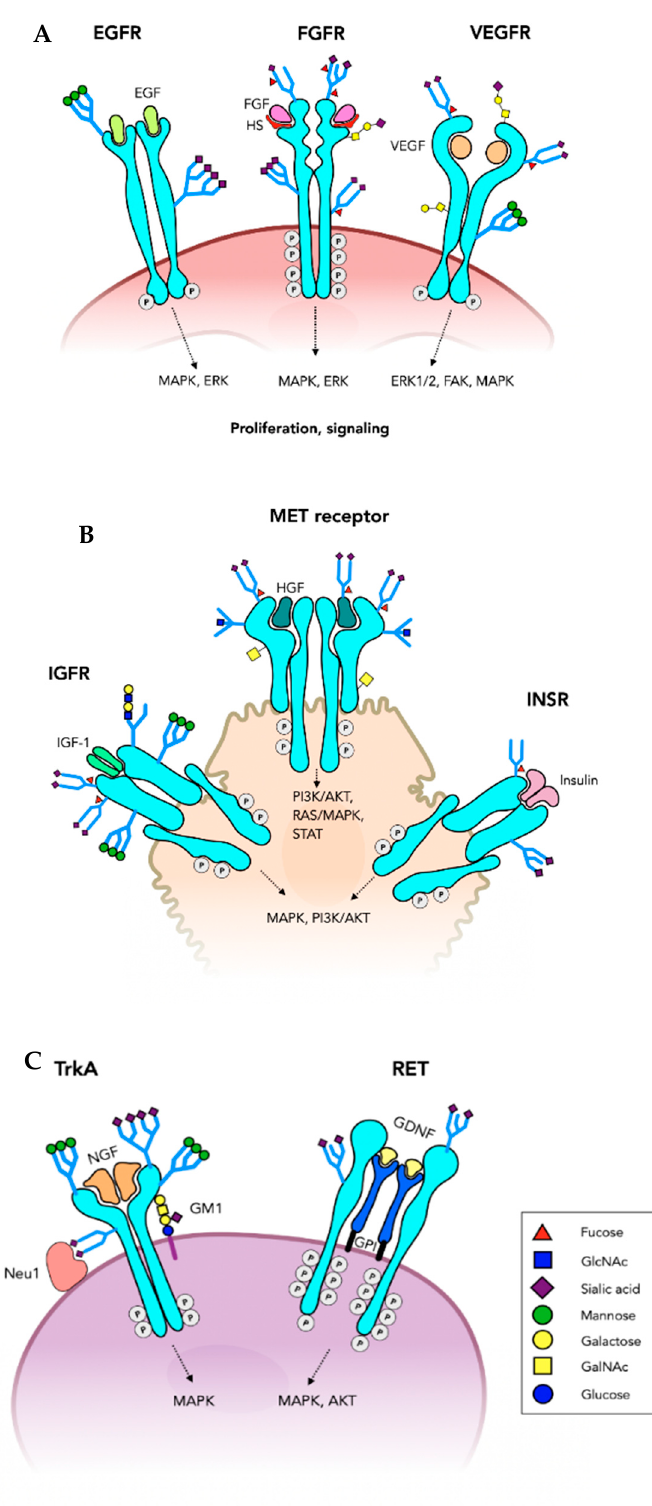
Figure 2. Tyrosine kinase receptors. Growth factor receptors have an extracellular domain that binds a growth factor and a cytoplasmic Tyrosine kinase domain (oncoprotein) that is essential for the signaling through a number of pathways that promote cell proliferation. Many of these receptors are of critical importance in tumor growth. Ligand binding induces receptor dimerization and activation of the Tyrosine kinases, phosphorylation of the cytoplasmic domain and induction of signaling pathways. ( A ) Only one of the N -glycans on each of the epidermal growth factor receptor (EGFR) subunits is